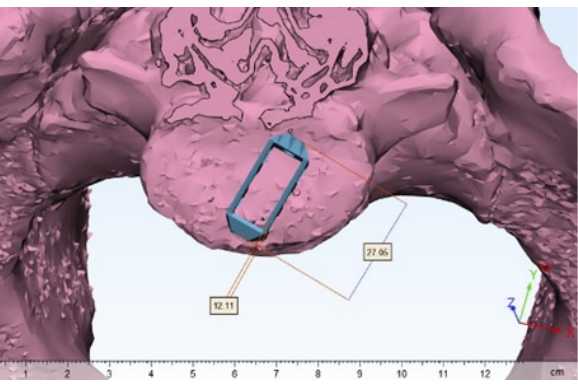
Figure 1. 3D modeling of the implant based on CT scan reconstruction.